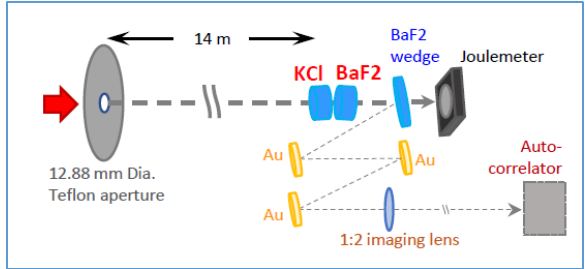
Fig. 1. Experimental setup for studying the